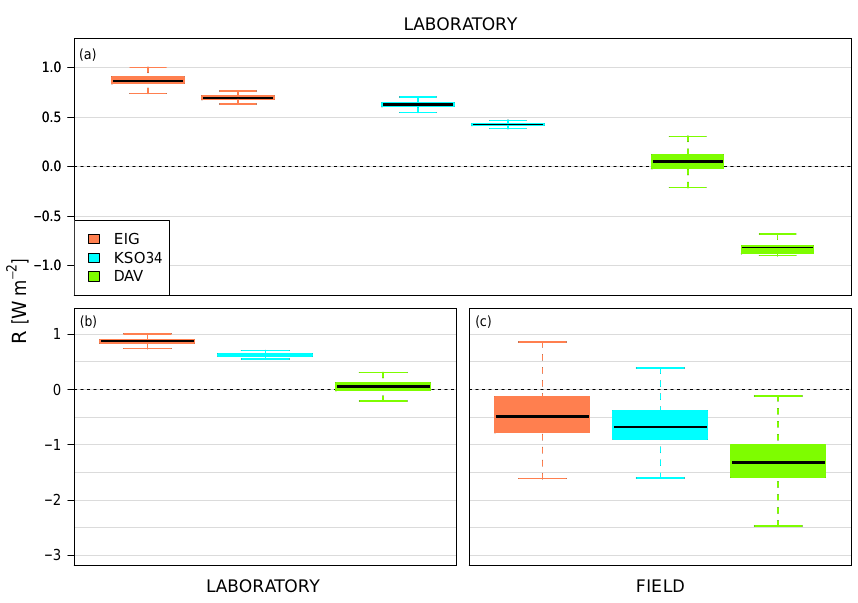
Figure 3. Spread of radiation ( R ) measurements with CMP21 pyranometers contained in different HV-systems (EIG, KSO34, and DAV) during dormant (i.e., undisturbed) phases for (a) and (b) , laboratory, and for (c) , field campaigns. Panel (a) provides results for two CMP21 pyranometers per HV-system as multiple instruments were available during the laboratory campaign.